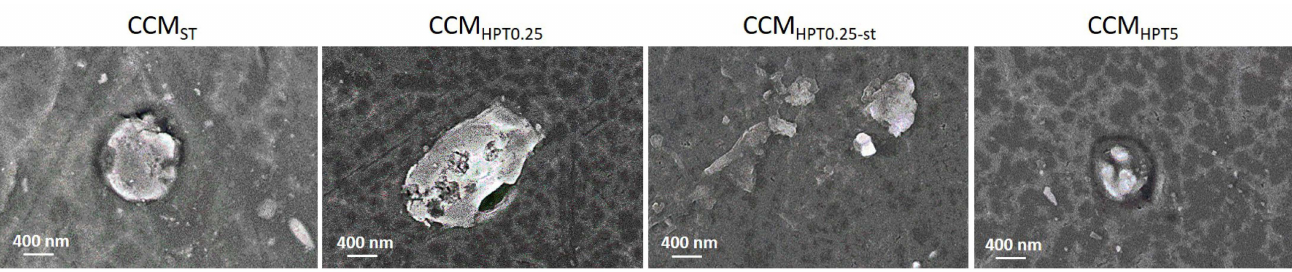
Figure 5. The surface morphology of the CCM samples after PDS tests.